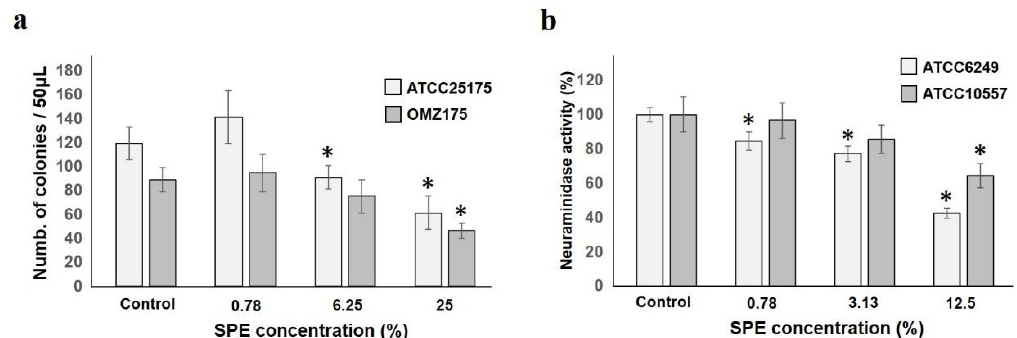
Figure 3. SPE is detrimental to adhesion and neuraminidase activity. ( a ): S. mutans ATCC25175 and S. mutans OMZ175 adhesion to HA pieces in SPE solution is shown. Colony number with regard to SPE dilution ratio are shown. ( b ): SPE inhibited S. oralis ATCC6249 and ATCC10557 neuraminidase activity is shown. Activity is suppressed in a concentration- dependent manner (result is shown as a ratio to that with 100% control). Each sample ( n = 6) indicated the statistical significance of difference between control and treated samples, determined using one-way ANOVA with Scheffe’s test (* p < 0.05).